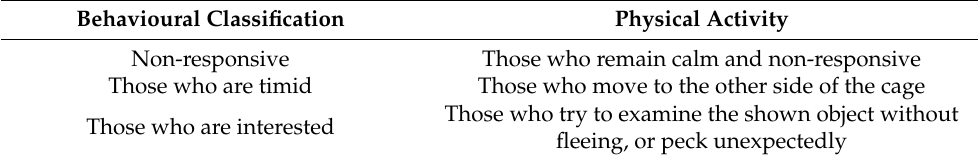
Table 4. The ethogram used to observe the behaviours of budgerigars in their cages for HCA. Behavioural Classification